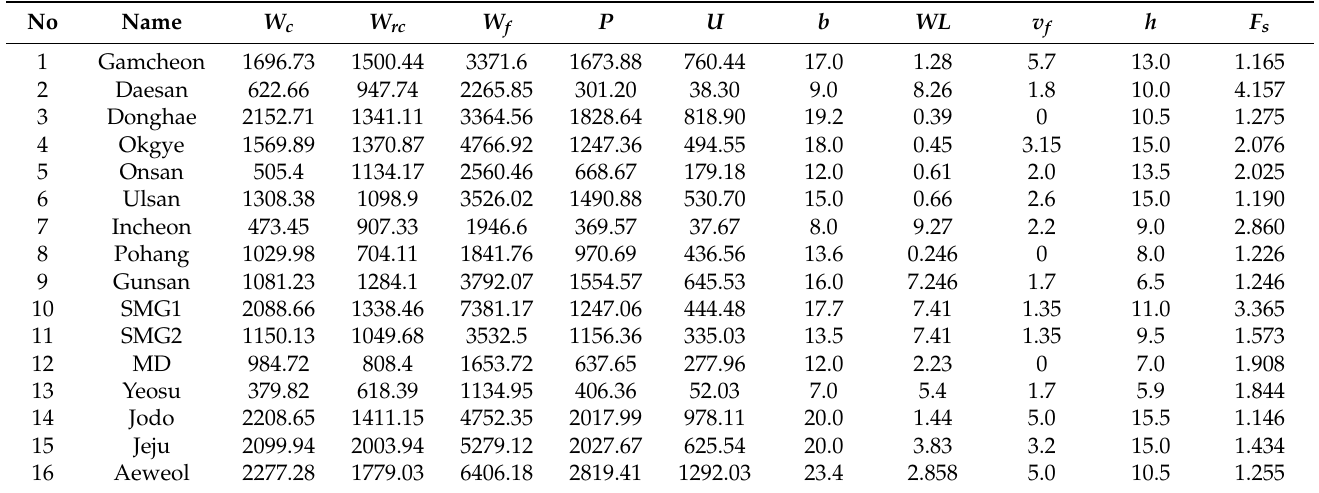
Table 1. Design values for 16 breakwaters (dim: kN, m).